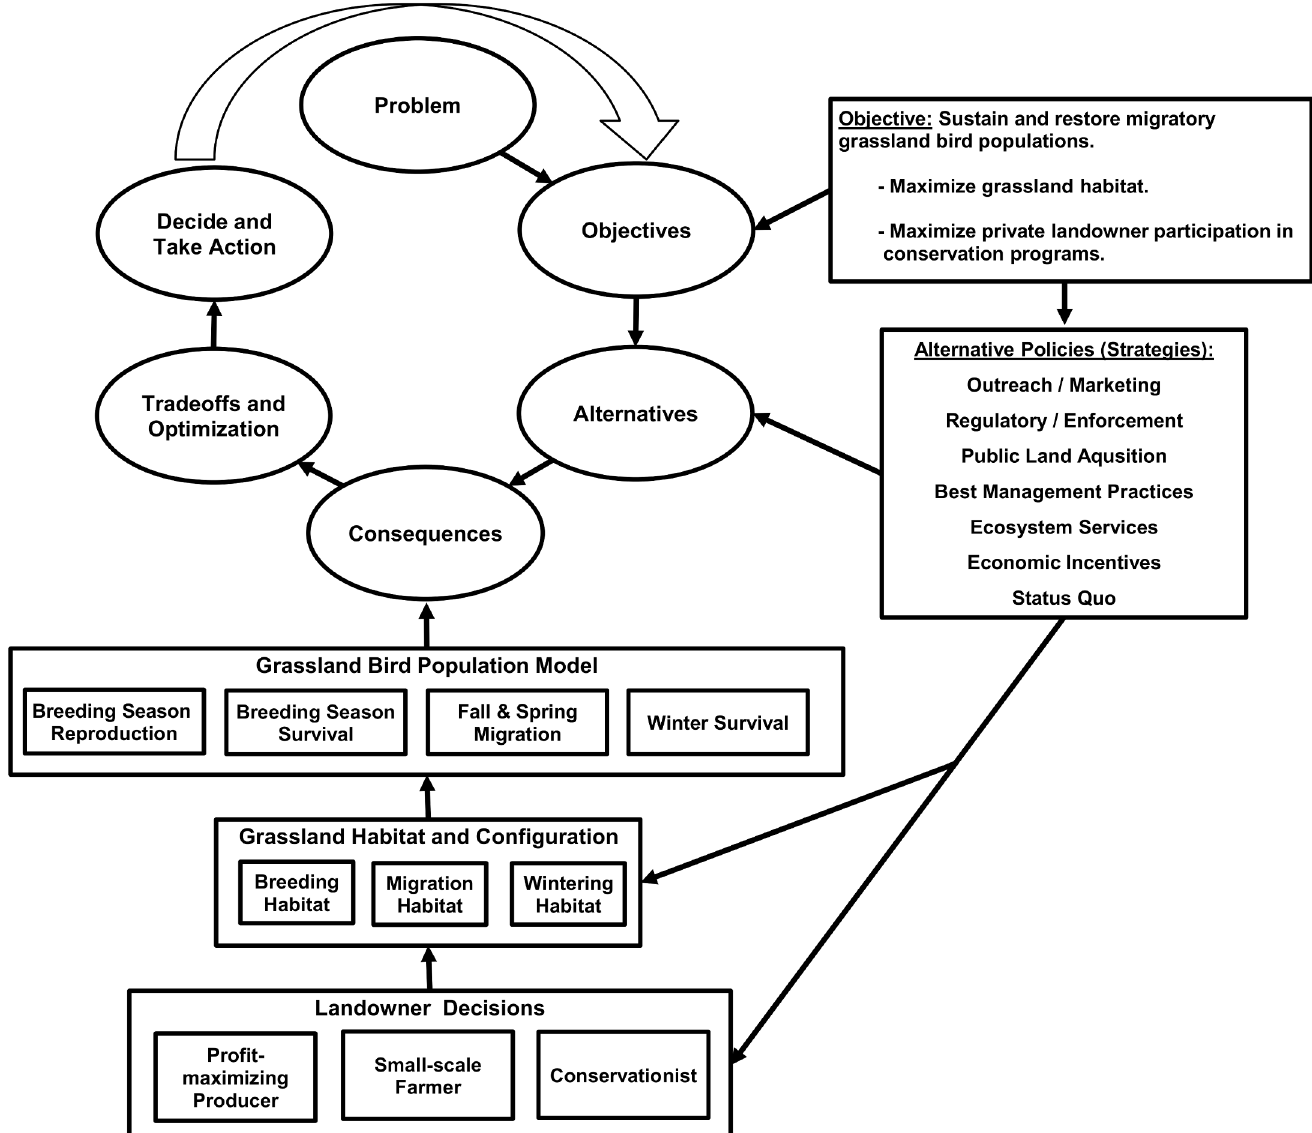
Fig 1. Integrated Modeling Framework. Policies influence landowner decision-making, the effect of which depends on the different landowner types ’ respective value systems. Landowner decisions affect habitat quantity and configuration, which function as inputs for the Grassland Bird Population